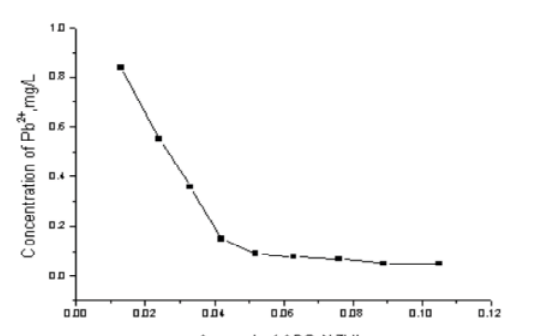
Figure 5. Effects of NZVI and modified NZVI nanoparticles on adsorption equilibrium time